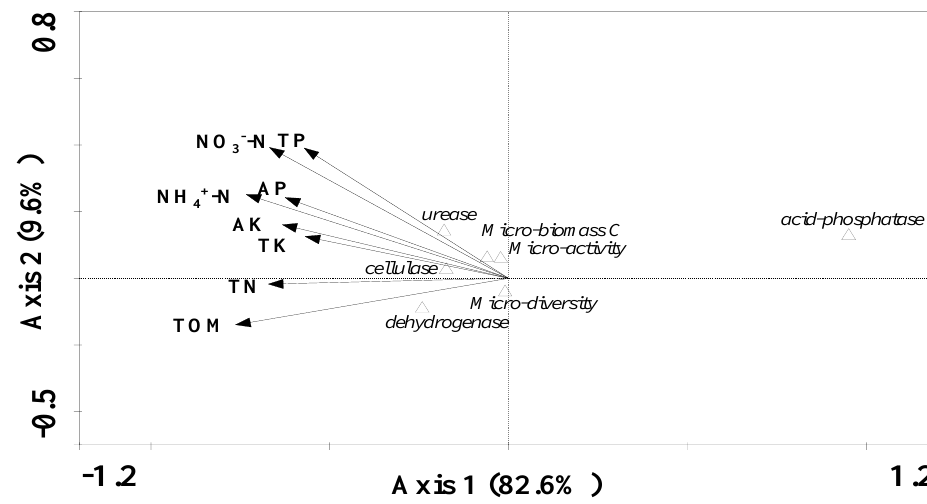
Figure 4. Canonical correspondence analysis (CCA) ordination diagram of microbial parameters with soil nutrient factors. The soil nutrient factors are represented as arrows and microbial parameters are shown as triangles.